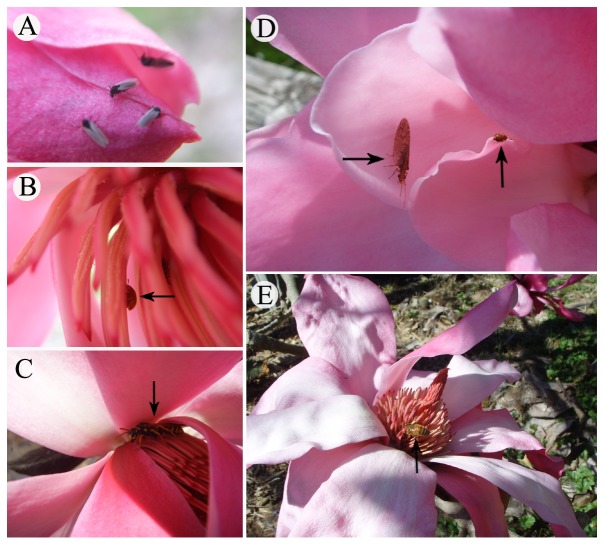
Flower-visiting insects at different stages of anthesis.(A) Aggregation of Bibio sp. on the surface of a swollen bud during the pre-pistillate stage. (B) Epuraea sp. foraging for pollen when the anthers were dehisced. (C) Polistes chinensis in a floral chamber at the staminate stage. (D) Brown lacewing (Hemerobiidae, Neuroptera) (left) and Epuraea sp. (right) crawling on the inner petals during the staminate stage. (E) Apis cerana foraging for pollen at the post-staminate stage.